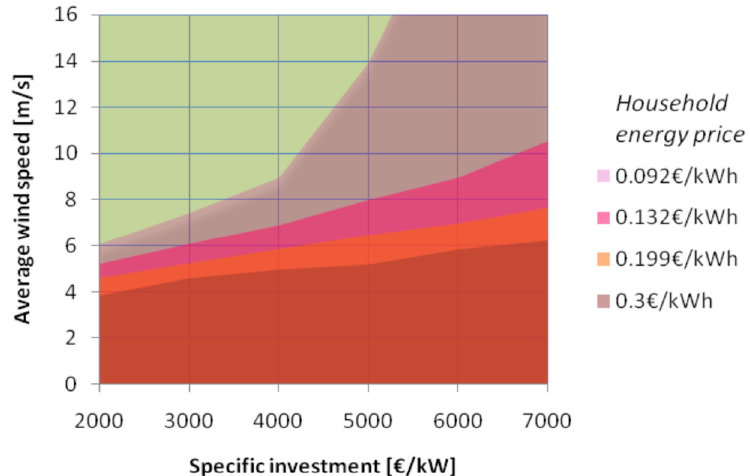
Fig. 4. Investment viability of on-grid